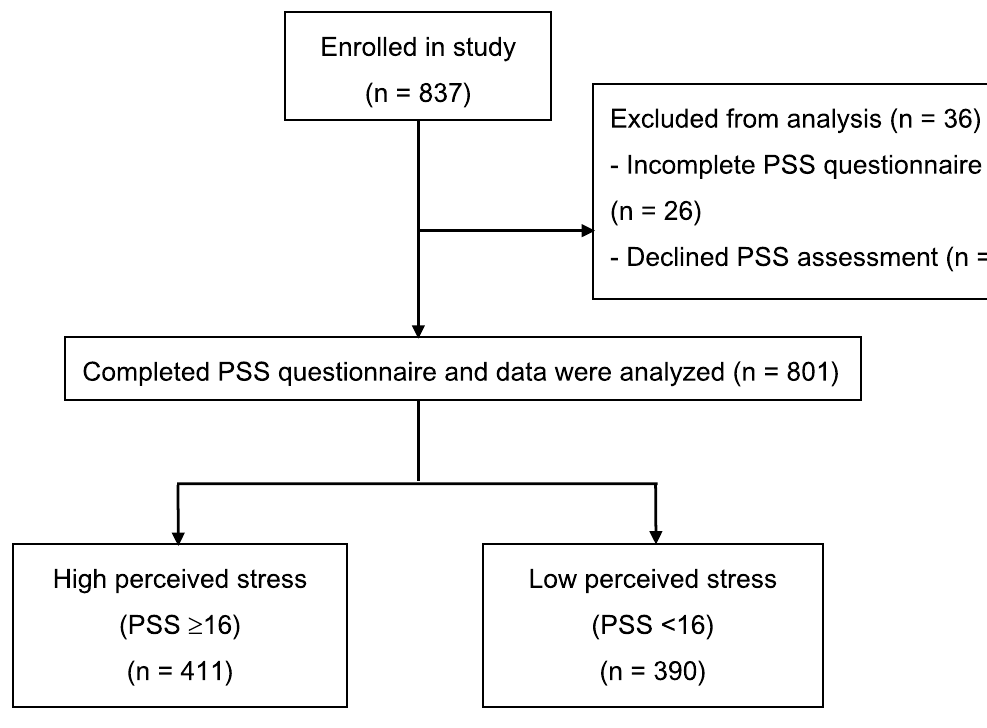
Figure 1. Study flowchart. Validated assessments were administered after initiation of epidural analgesia, with the patient